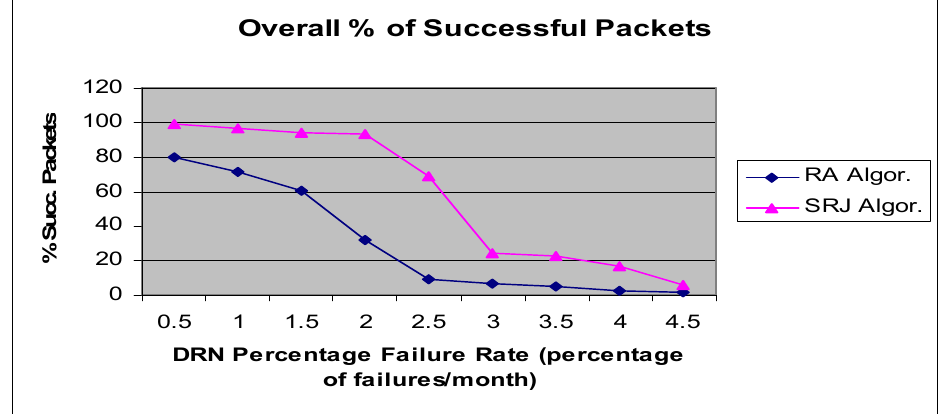
Figure 14. Simulation results for the hierarchical acoustic wireless sensor network. Percentage of successfully transmitted packets. NUM_DRN_PER_DDN =